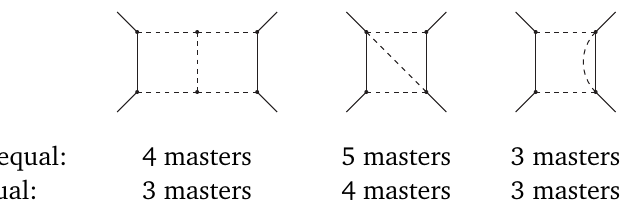
Figure 2: Topologies with a dependence up to weight 4 on a non-trivial subset of the square